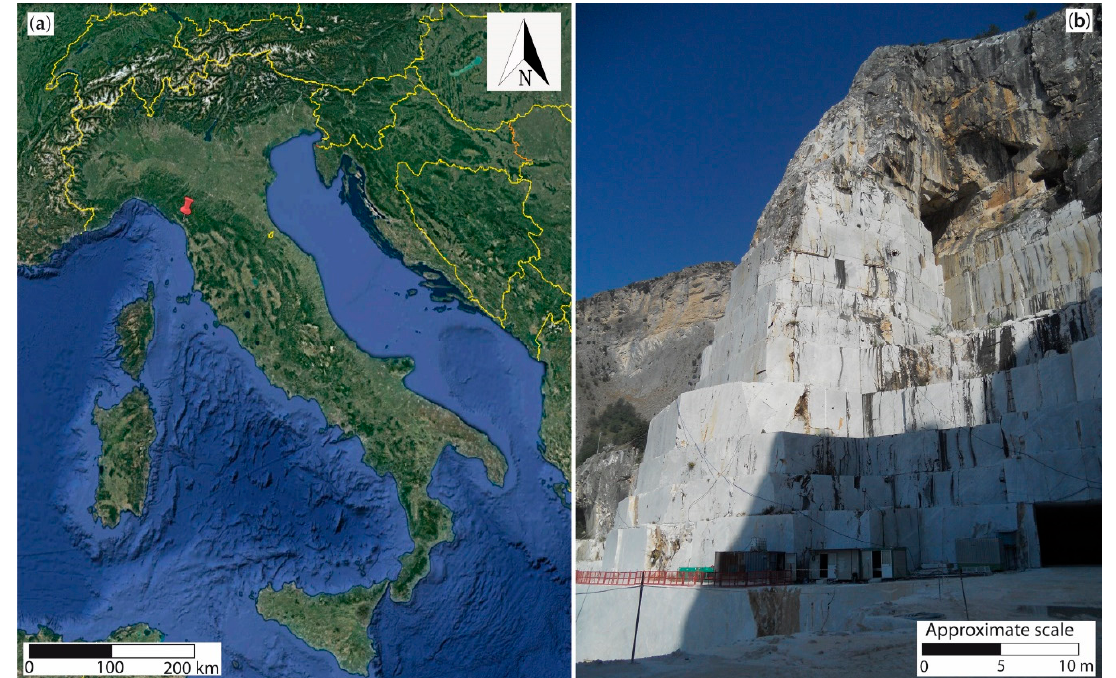
Figure 1. ( a ) Location of the Lorano marble quarry in Italy. ( b ) Panoramic image of the investigated Pradetto cut site.